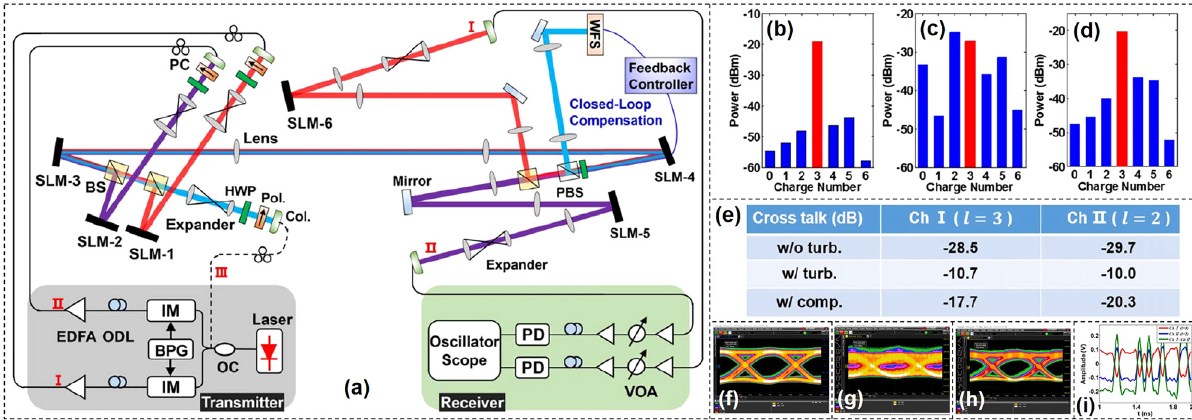
Figure 19: High-speed Bessel beams encoding/decoding. (a) Experiment setup of high-speed encoding/decoding of Bessel beams through turbulence assisted by adaptive compensation. OC, optical coupler; BPG, bit-pattern generator; IM, intensity modulator; ODL, optical delay line; EDFA, erbium-doped fiber amplifier; PC, polarization controller; SLM, spatial light modulator; Col., collimator; Pol., polarizer; HWP, half-wave plate; BS, beam splitter; PBS, polarization beam splitter; WFS, wavefront sensor; VOA, variable optical attenuator; PD, photodetector. Measured power distributions of various channels with onlypathIon(b)withoutturbulence,(c)beforeand(d)aftercompensationwithturbulence.(e)MeasuredcrosstalksforchannelsIandIIinthe cases without turbulence (w/o turb.), with turbulence (w/turb.), and with compensation (w/comp.) of 20-Gbit/s Bessel beam encoding/ decoding link. Eye diagrams of Ch I for (f) back-to-back, Bessel beam decoding (g) before and (h) after compensation. (i) Temporal waveforms of two channels (Ch I, Ch II) and their subtraction (Ch I – Ch II) after turbulence compensation [71]. Reprint permission obtained from [71].